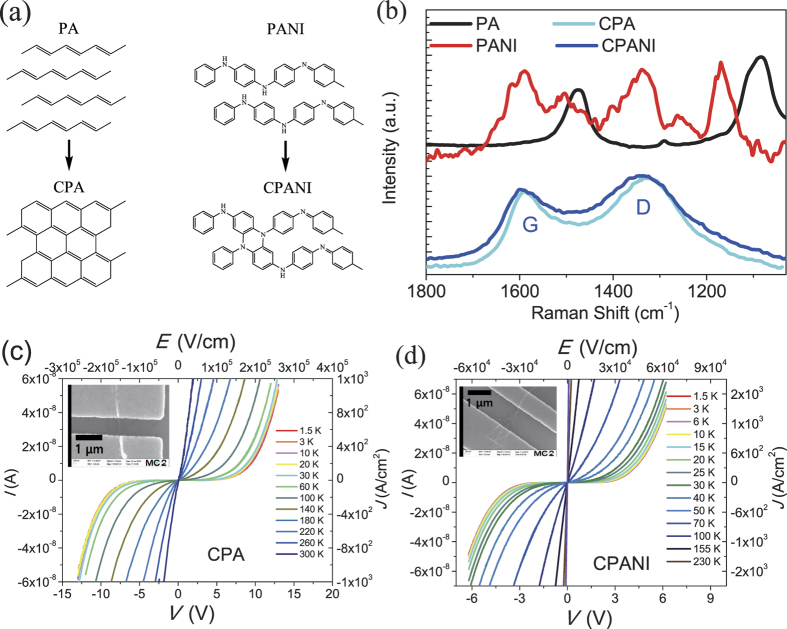
Structural differences between pristine and carbonized polymers and I-V characteristics of CPA and CPANI nanofibers.(a) Possible cross-linking of PA (adapted from ref. 30) and PANI (adapted from refs 33 and 34) after carbonization at 800 °C. (b) Raman spectra of PA and PANI nanofibers show characteristic peaks of trans-PA at 1475 and 1085 cm−1 and complex peaks of HCl doped PANI at 1620, 1590, 1505, 1405, 1340, 1260, and 1170 cm−1. After carbonization, broad graphite G and disordered D bands were observed in both CPA and CPANI nanofibers. Data for PA and PANI are normalized with respect to the intensity of D band and shifted for clarity. (c,d) I-V (E-J) characteristics of CPA (c) and CPANI (d) nanofibers. Inset figures are scanning electron microscope (SEM) images of CPA (c) and CPANI (d) nanofibers with Ti/Au top contact electrodes.